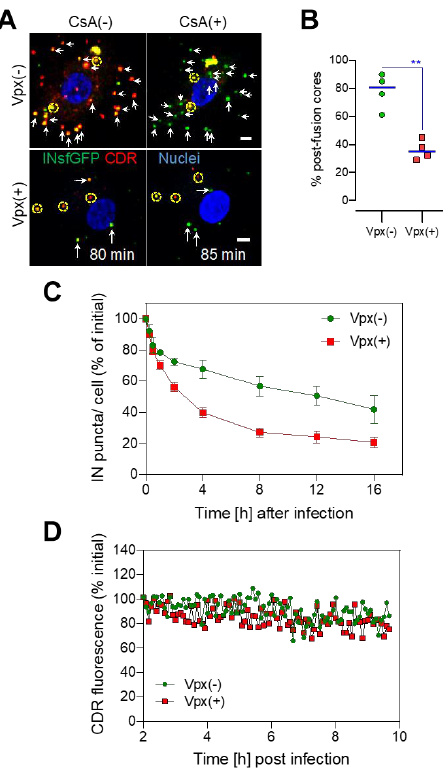
Figure 3. SAMHD1 depletion accelerates early cytoplasmic uncoating. MDMs treated with Vpx(+) or Vpx(−) SIV-VLPs were infected at MOI 0.5 with VSV-G-pseudotyped HIV-1 colabeled with INsfGFP (green) and CDR (red). ( A ) Shown are images of Vpx(−)- and Vpx(+)-treated MDMs at 80 min post-infection taken immediately before (CsA(−), left panel) and 5 min after cyclosporine A (CsA) addition (CsA(+), right panel) which resulted in a loss of CDR from post-fusion cytoplasmic viral cores (arrows) and not from intact virions (dashed yellow circles). Scale bar 5 μm. ( B ) The fraction of post-fusion cores surviving beyond 80 min post-infection in MDMs treated with Vpx(−) and Vpx(+) SIV-VLPs was determined by subtracting the number of viruses that did not lose CDR after CsA addition and normalizing to the initial number of cell-bound viruses at T = 0 min. Mean values (blue lines) from multiple experiments for 4 donors (data points) are shown. ( C ) The fraction of INsfGFP-labeled HIV-1 complexes that retained CDR signal in the MDM cytoplasm was normalized to the initial number of cell-associated viruses. Error bars are SEM from 20 randomly selected cells. ( D ) Average CDR fluorescence intensity of cores in the MDM cytoplasm imaged for 8 h starting at 2 hpi. Data show that regardless of Vpx(+) treatment HIV-1 cores may retain the CDR for a long time. Tracks are ensemble averages of n = 3 and n = 4 randomly selected cytoplasmic cores in Vpx(−)- and Vpx(+)-treated MDMs, respectively. Error-bars are STD. ∗∗ denote p < 0.01, respectively.